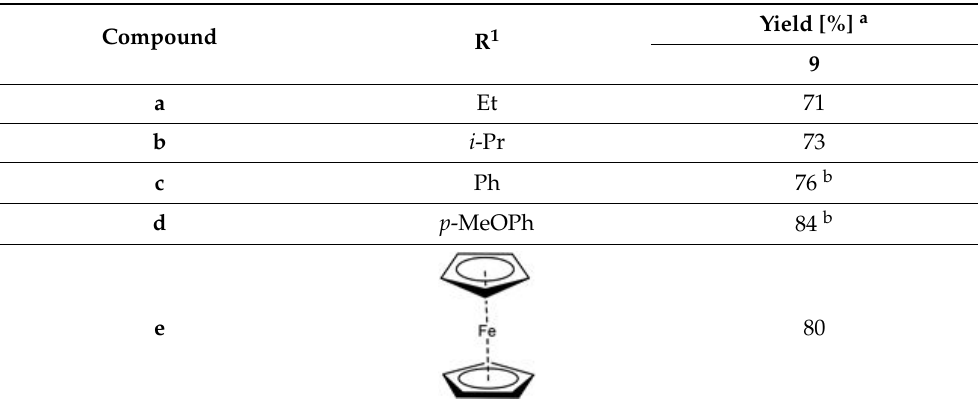
Table 1. Yields of diethyl 4-hydroxy-2-oxoalkylphosphonates 9a-e .